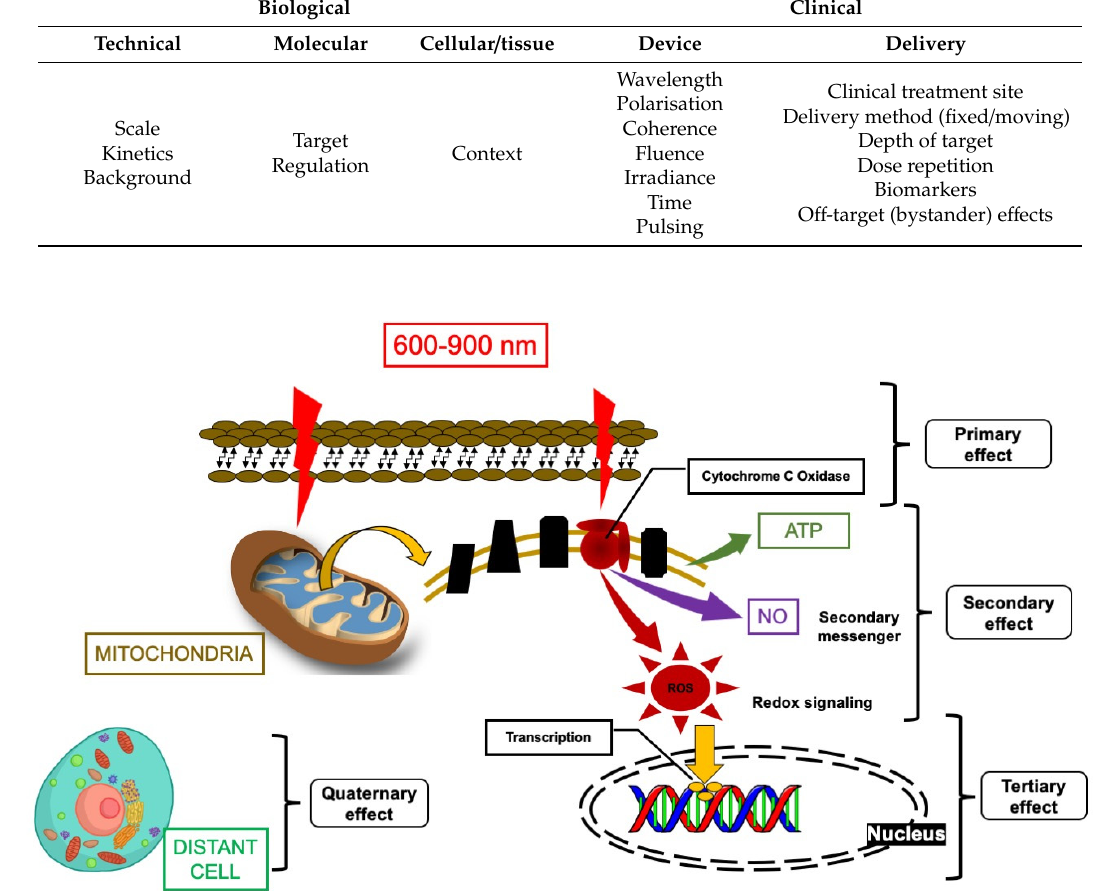
Figure 1. Modified schematic description of the PBMT’s effects on stressed tissue, highlighted in 4 stages: primary effects (photonic energy absorption by cytochrome C Oxidase (CCO)), secondary effects (mitochondrion of ATP, NO, and ROS), tertiary effects (downstream of intracellular responses (Gene transcription and cellular signaling)), and quaternary effect (indirect/distant effects) [4] . Abbreviations: PBM, photobiomodulation; ROS, reactive oxygen species; NO, nitric oxide; ATP, adenosine triphosphate .